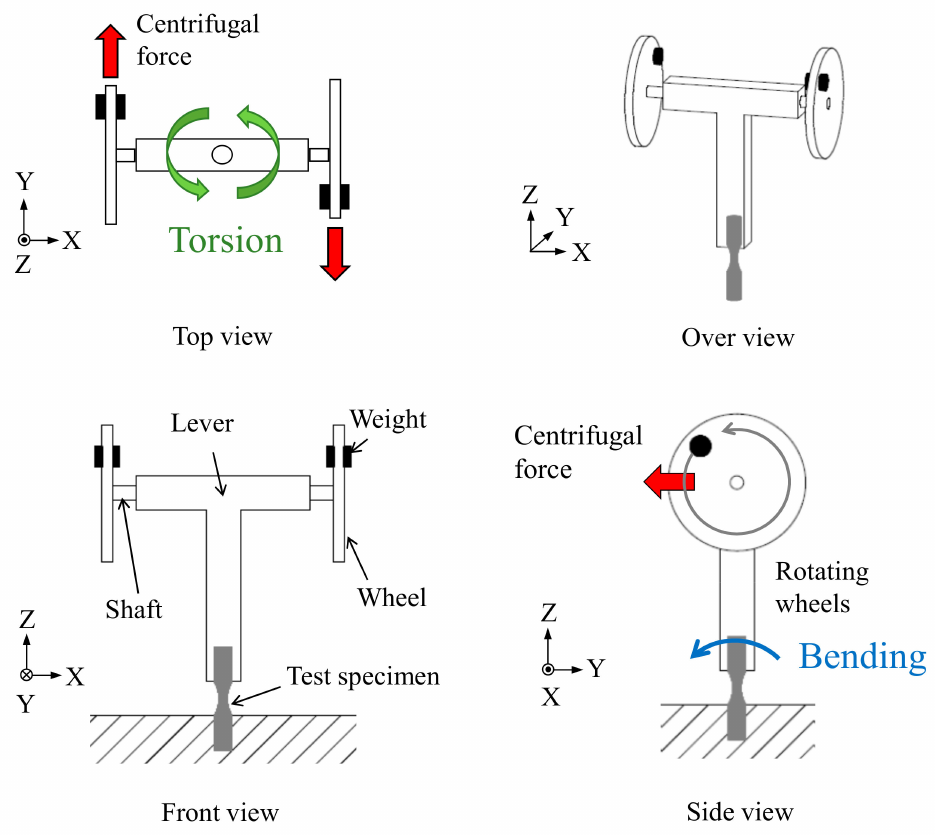
Figure 2. Schematic view of the testing machine developed in this research.